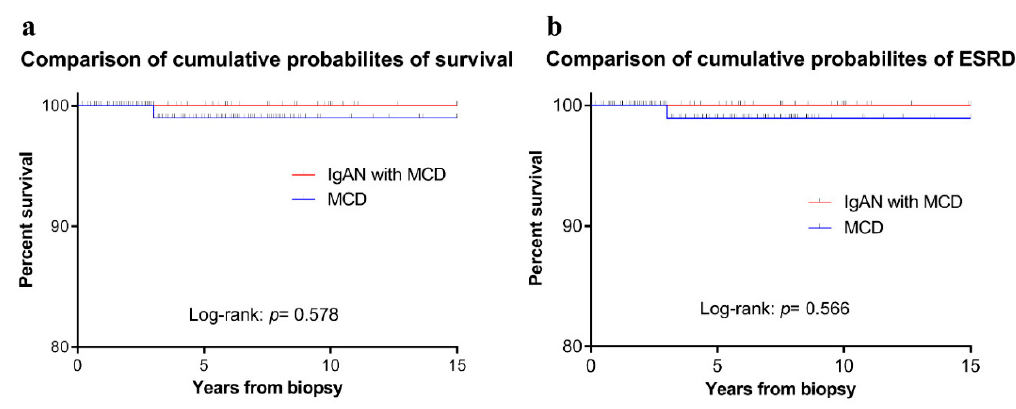
Figure 2. ( a ) Comparison of cumulative probabilities of survival; ( b ) Comparison of cumulative Figure 2. Comparison of cumulative probabilities of survival and end-stage renal disease (ESRD) probabilities of end-stage renal disease (ESRD) between IgA nephropathy with minimal change disease between IgA nephropathy with minimal change disease (IgAN-MCD) and MCD patients. (IgAN-MCD) and MCD